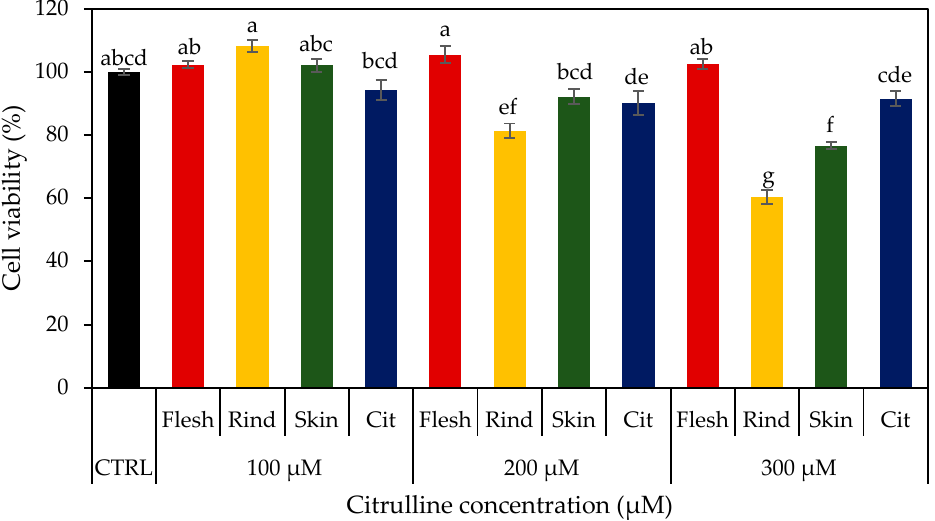
Figure 2. Cell viability of Caco-2 cells treated with different parts of watermelon samples and L- citrulline (100–300 µM citrulline). Data are expressed as the mean ± SEM (n = 12). Means followed by a different letter are significantly different at the 5% level. CTRL = control; Cit =